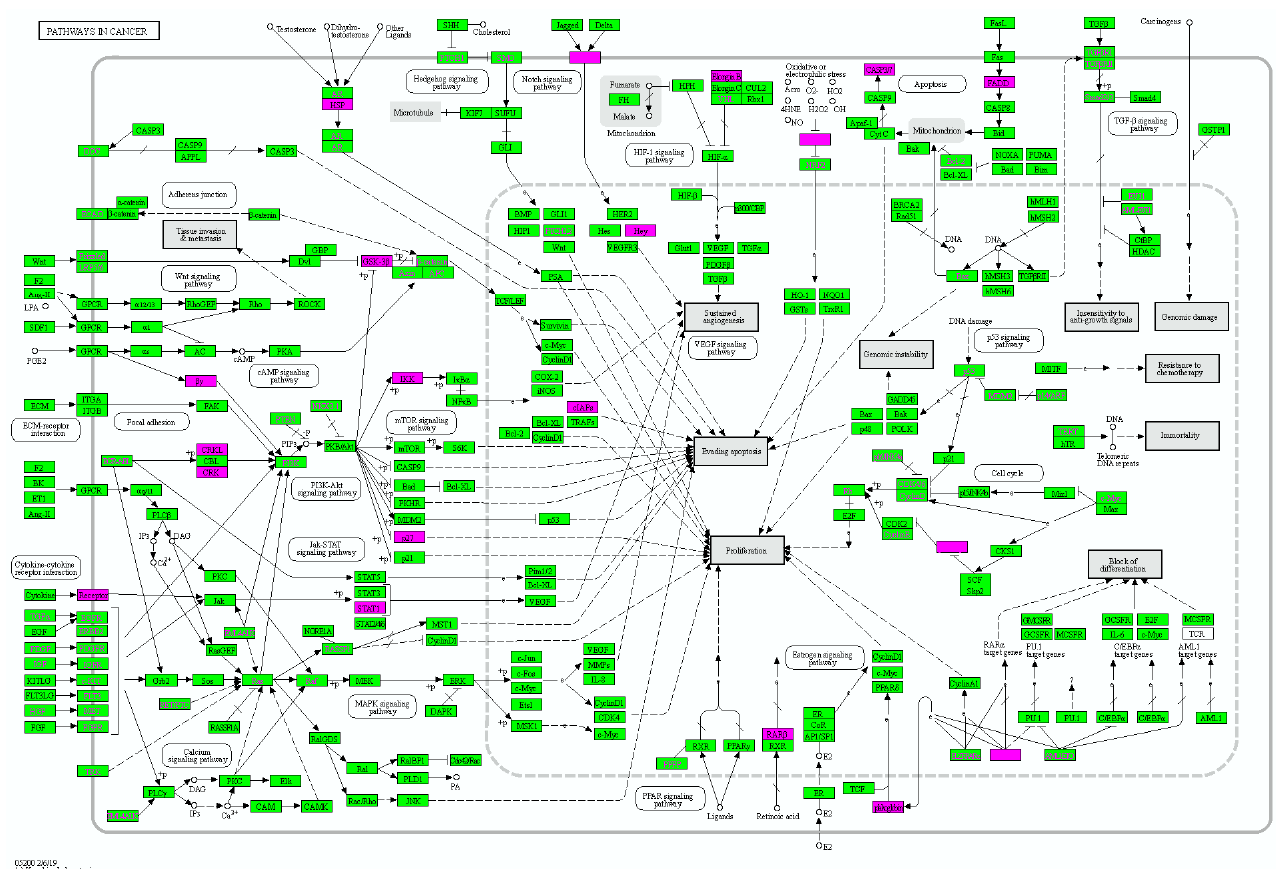
Figure 3. Enriched pathway visualization with KEGG Mapper Color. DEG-mapped pathway visualization presented that DEGs were mainly involved in “Signal transduction metabolism”, such as the PI3K/Akt, JAK/STAT, and Notch signaling pathways, and were specifically enriched in “PI3K/Akt signaling pathway”. All pathways were directed towards “Sustained Angiogenesis”, “Evading Apoptosis”, and “Proliferation”. Table 3. Significant BP terms of 133 upregulated DEGs overlapped with